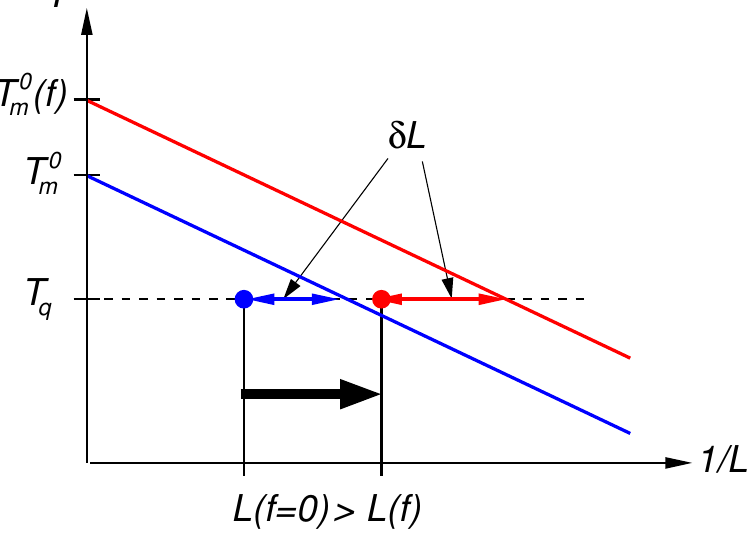
Figure 1. Sketch of the state diagram. The x-axis denotes the inverse stem length and the y-axis represents the temperature. The equilibrium melting temperature without perturbation by the external force is given by T 0 m . The force field leads to a shift towards higher equilibrium melting temperatures, T 0 m ( f ) . The Gibbs–Thomson melting point depression due to the surface tension of the lamellae is represented by straight lines in this representation. Upon quenching, in order to form a stable-growing state, the selected lamellar thickness has to be larger then the stability limit which can be represented by offset of δ L (double arrows) with respect to the Gibbs–Thomson line. The crystallization states are indicated by the full circles. The expected shift in the lamellar thickness due to application of force is indicated by the black